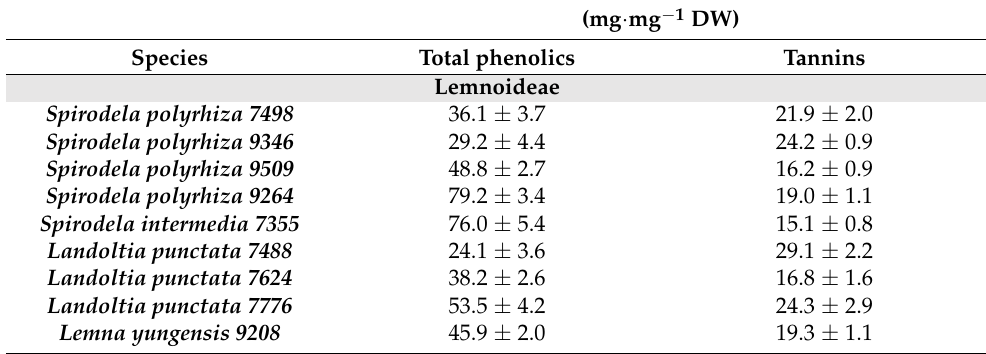
Table 6. Phenolics and tannin levels (mg · mg − 1 dry weight) of 21 duckweeds species. Data repre- sented by the mean ± standard error ( n =